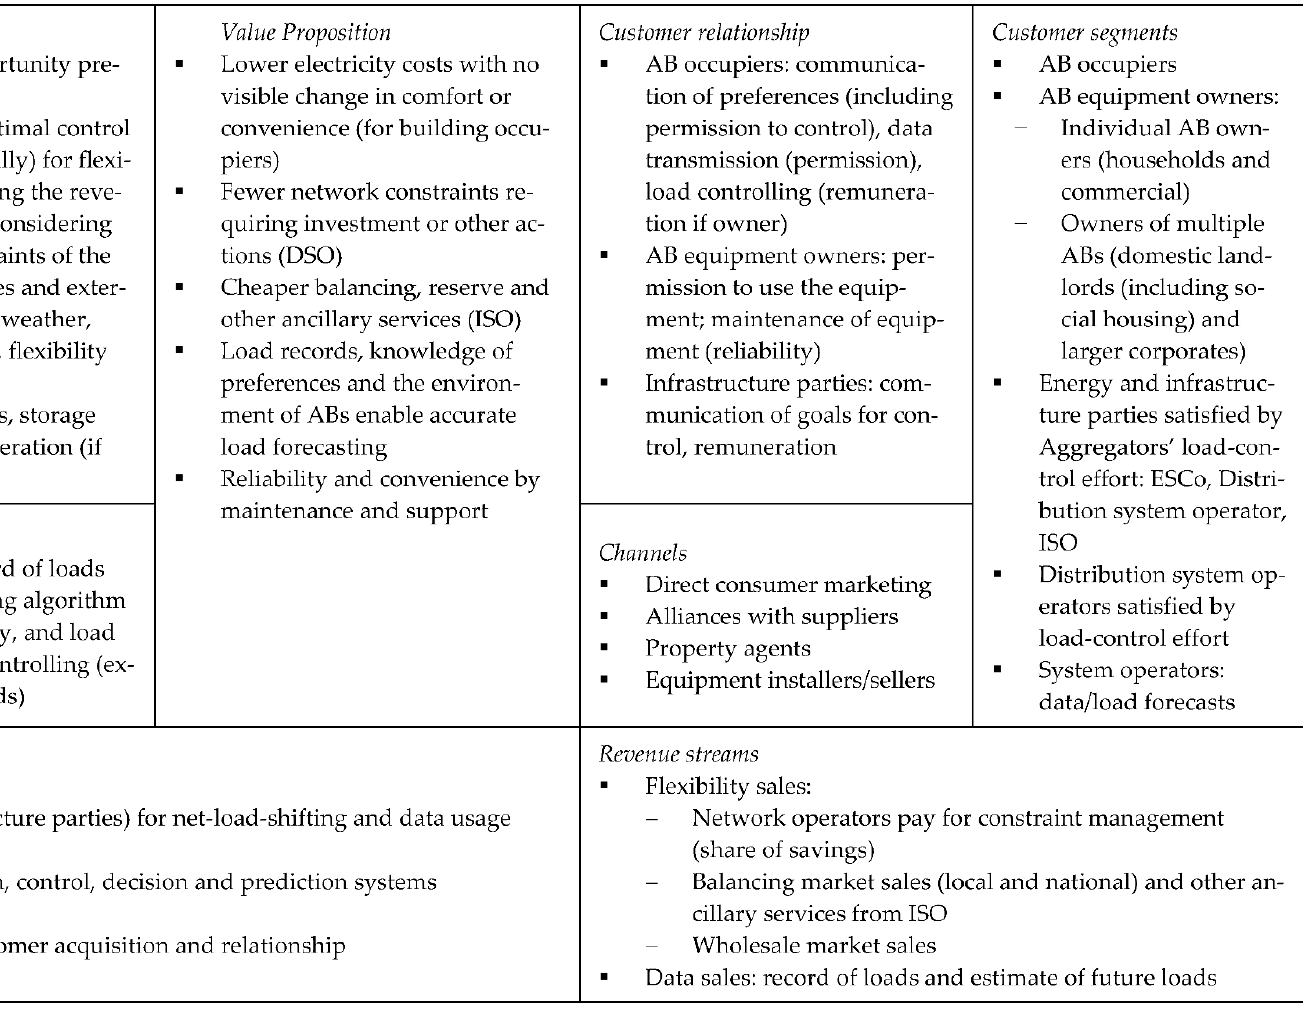
Figure 4. The AB-Aggregator.